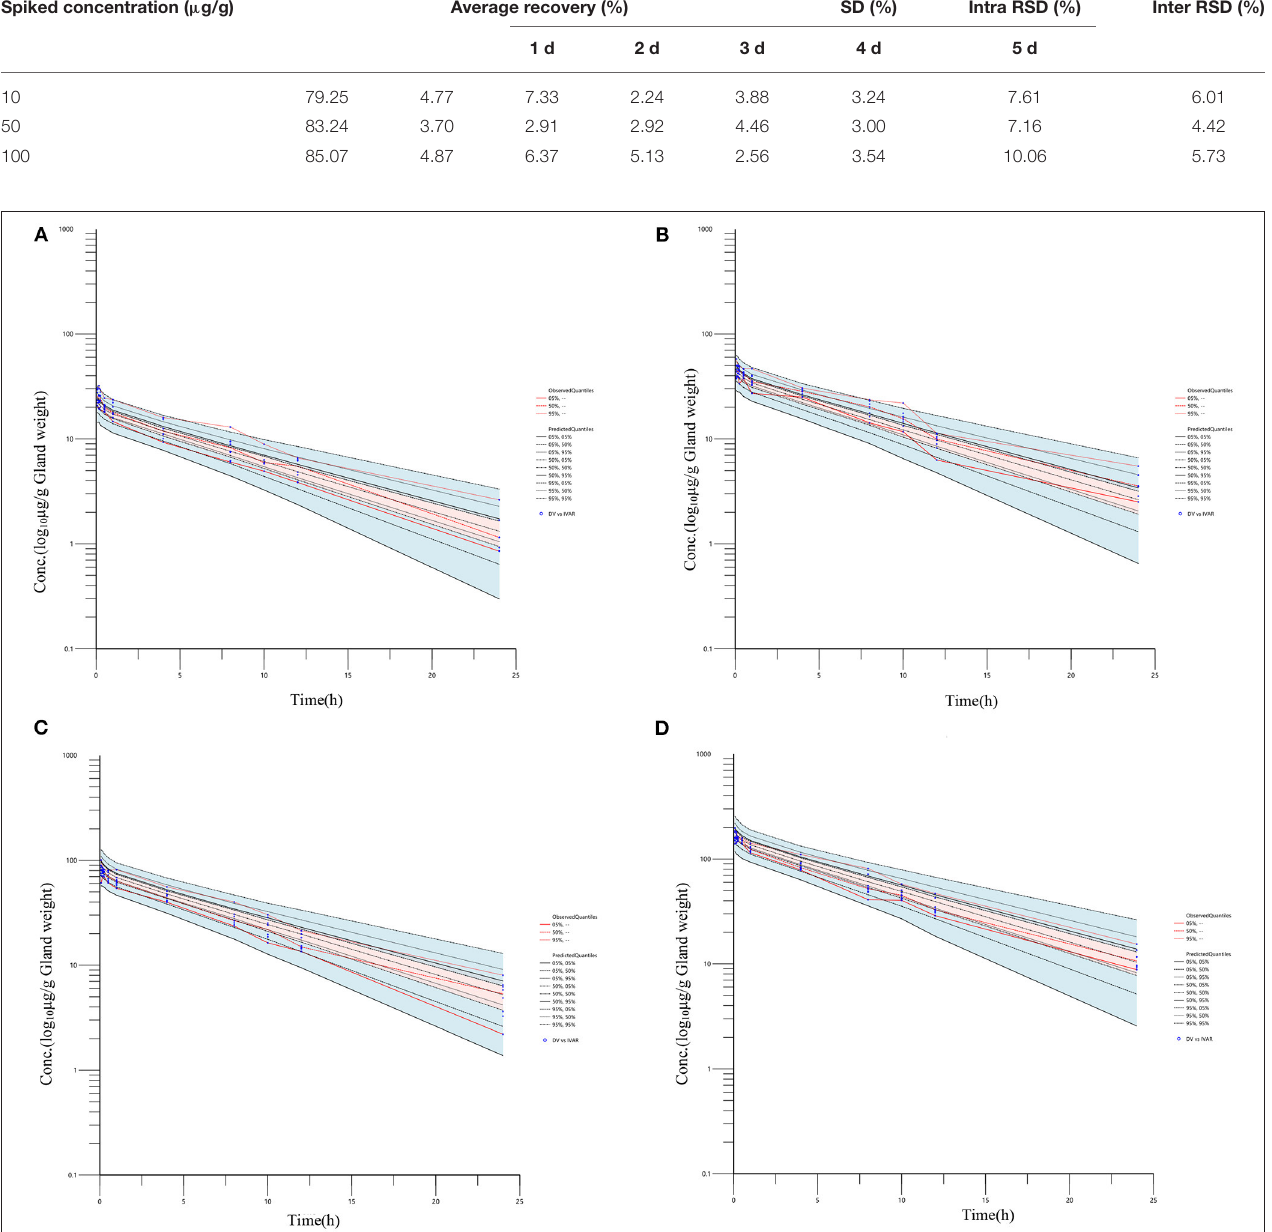
TABLE 2 | The average recovery, intra RSD and inter RSD of rifaximin in mammary gland at three spiked concentration. Spiked concentration ( µ g/g)